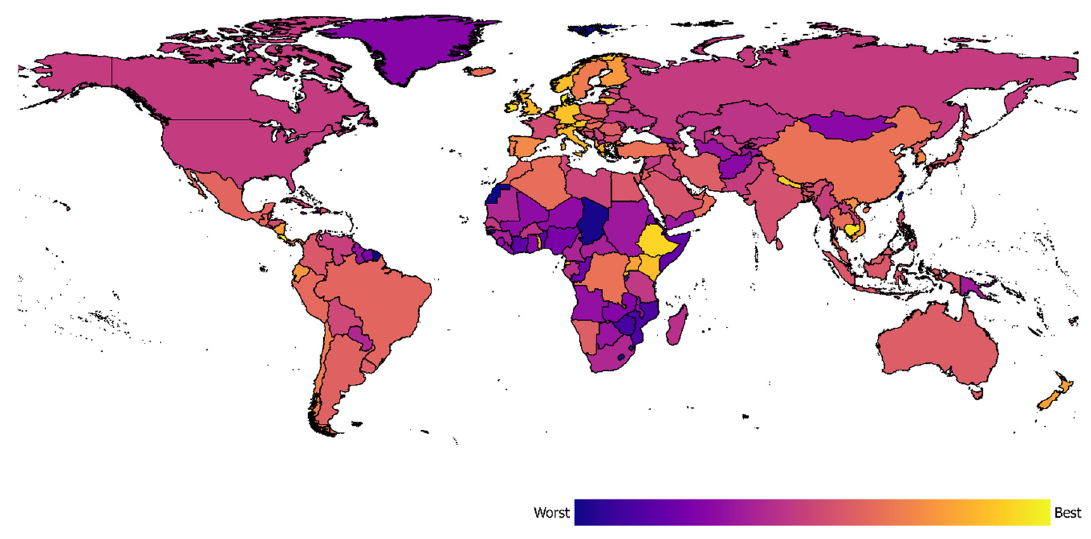
Figure 8. Global view on the timeframe dimension.